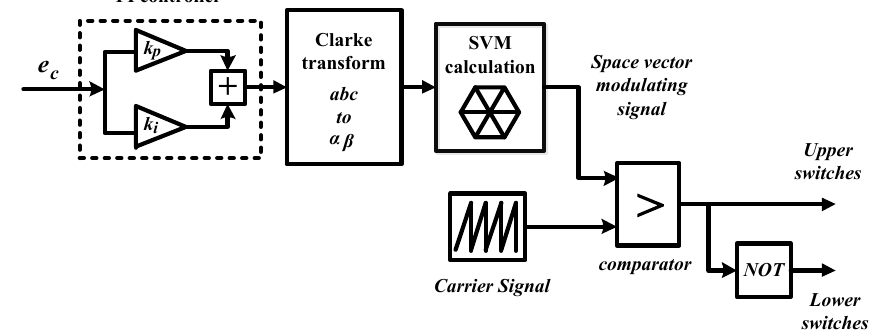
Figure 11. Conceptual model of a current control scheme based on the space vector modulation (SVM) technique [71,72].